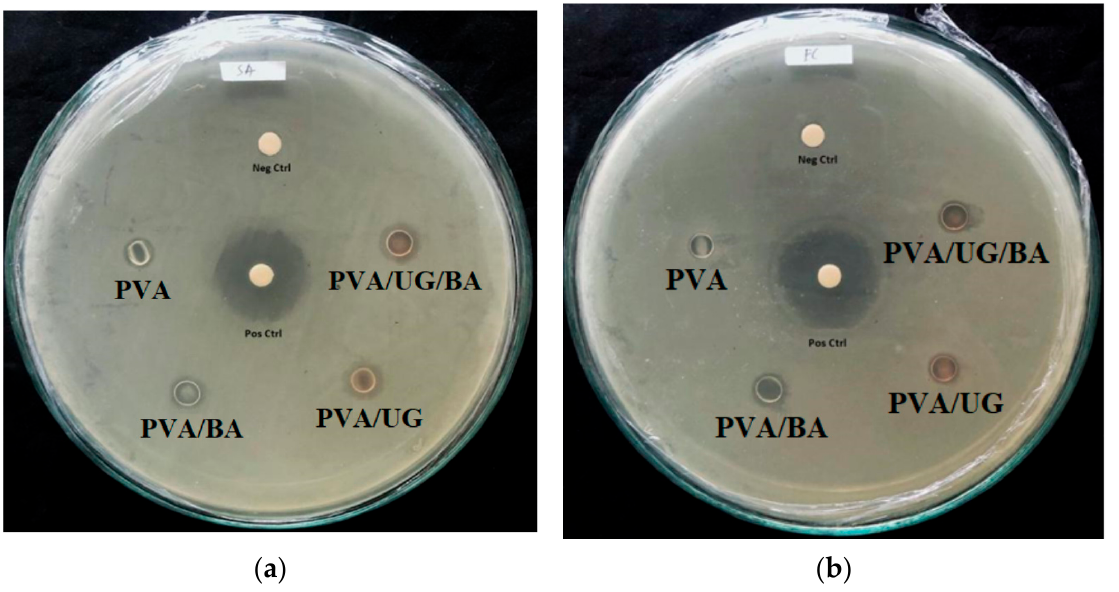
Figure 8. Antibacterial characteristics of samples (red arrow on transparent area diameter) against ( a ) Staphylococcus aureus (SA) and ( b ) Escherichia coli (EC). (Neg Ctrl) = negative control; (Pos Ctrl) = positive control (chloramphenicol). Table 2. Antimicrobial resistance of